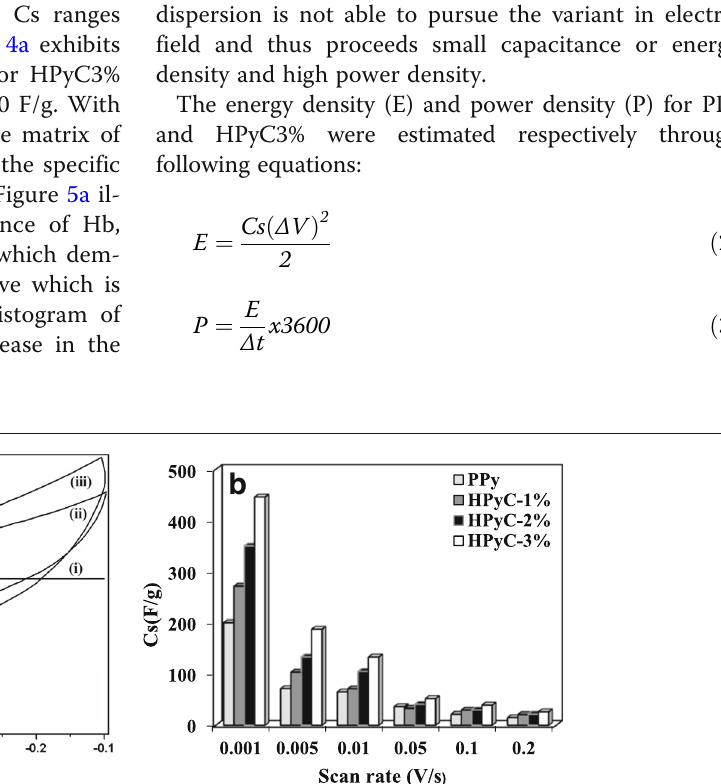
Fig. 5 a CV of Hb, PPy and HPyC3% (i – iii) at 0.01 V/s. b Specific capacitance of all materials